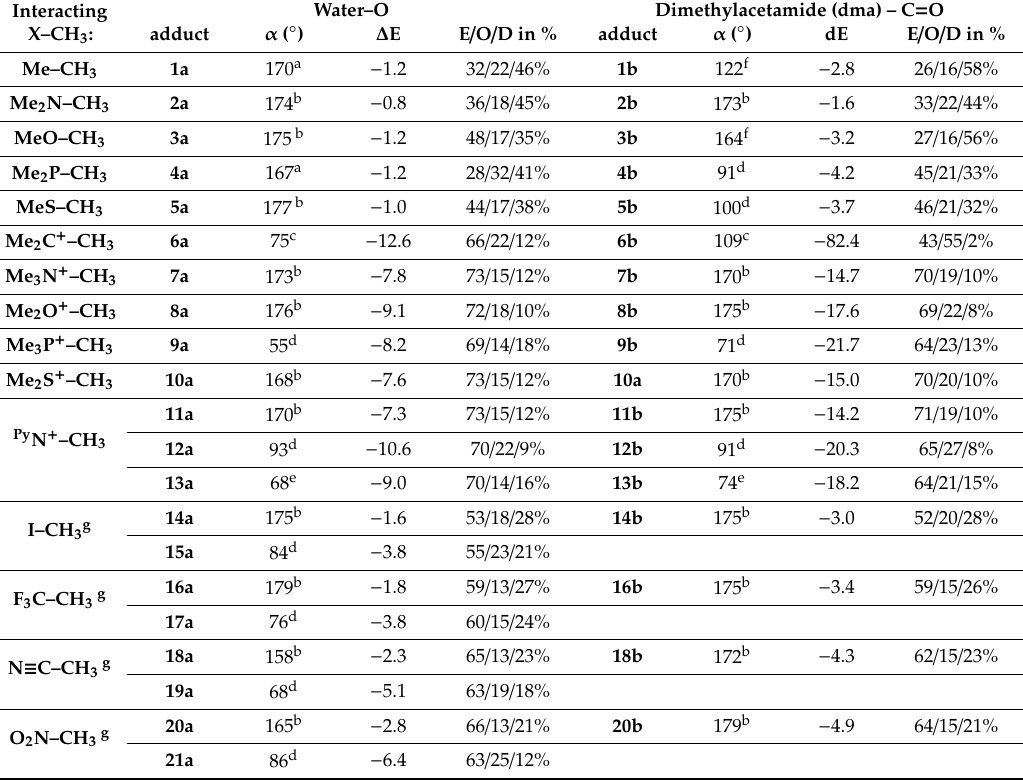
Table 1. Numerical overview of adducts computed with DFT between an indicated X-CH 3 methyls and water (adducts ‘a’) or dimethylacetamide (dma, adducts ‘b’). Using ADF at the B3LYP-D3 / def2-TZVP level of theory, interaction energies (in kcal · mol − 1 ) were computed and an energy decomposition analyses is shown as a percentage of the total amount of interaction energies split up as electrostatic (E), orbital (O) and dispersion (D) interactions. Entries in grey are not consistent with a Carbon bonding geometry. See Figure S4 for perspective views and atoms in molecules